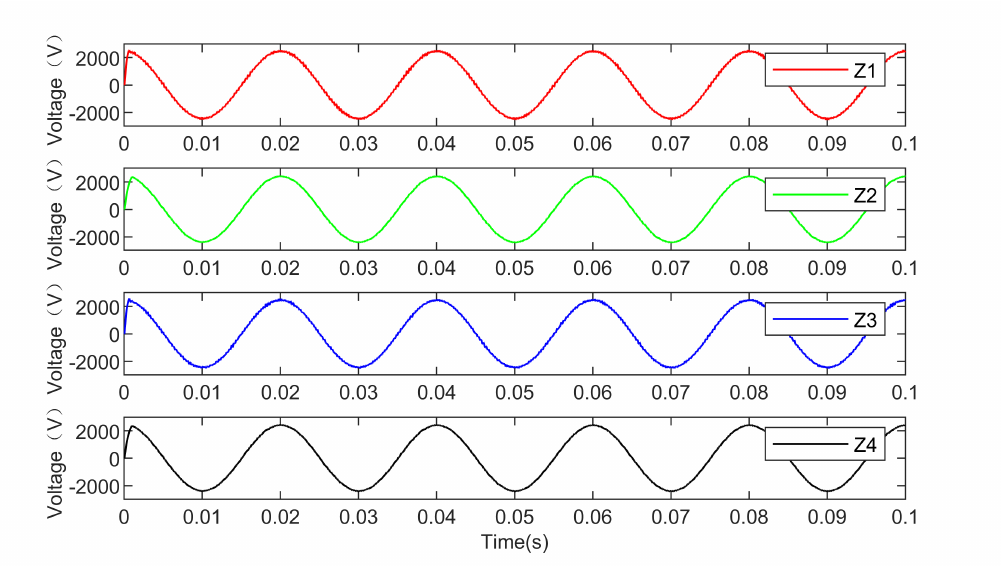
Figure 6. Output voltage waveform under four load conditions.